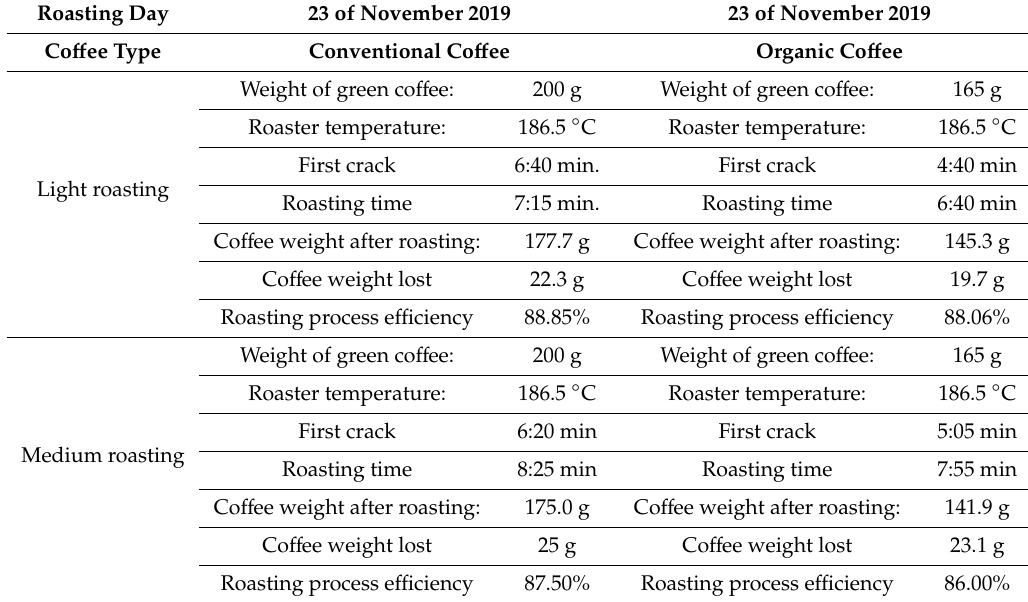
Table 1. Co ff ee roasting